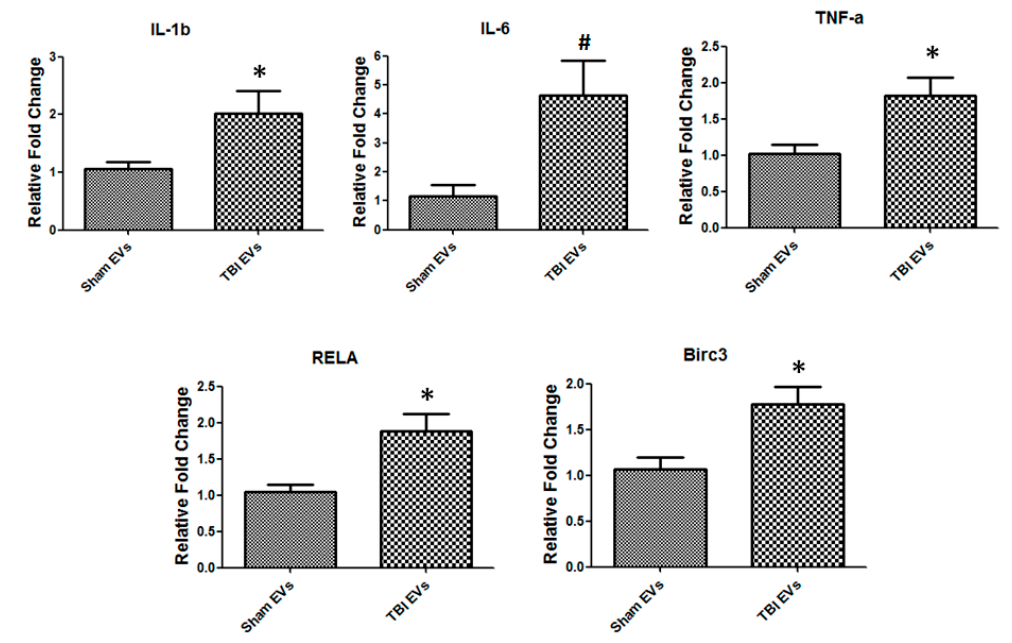
Figure 8. TBI derived bone marrow EVs regulate inflammatory and NF-kB signaling gene expression. Bone marrow cells treated with sham and TBI derived EVs at concentrations of 20 µg/mL for 36 h followed by RT-PCR, IL-1, IL-6II, TNF-a, and RelA/p65 and Birc3 ( n = 6, * p < 0.05, # p < 0.01).